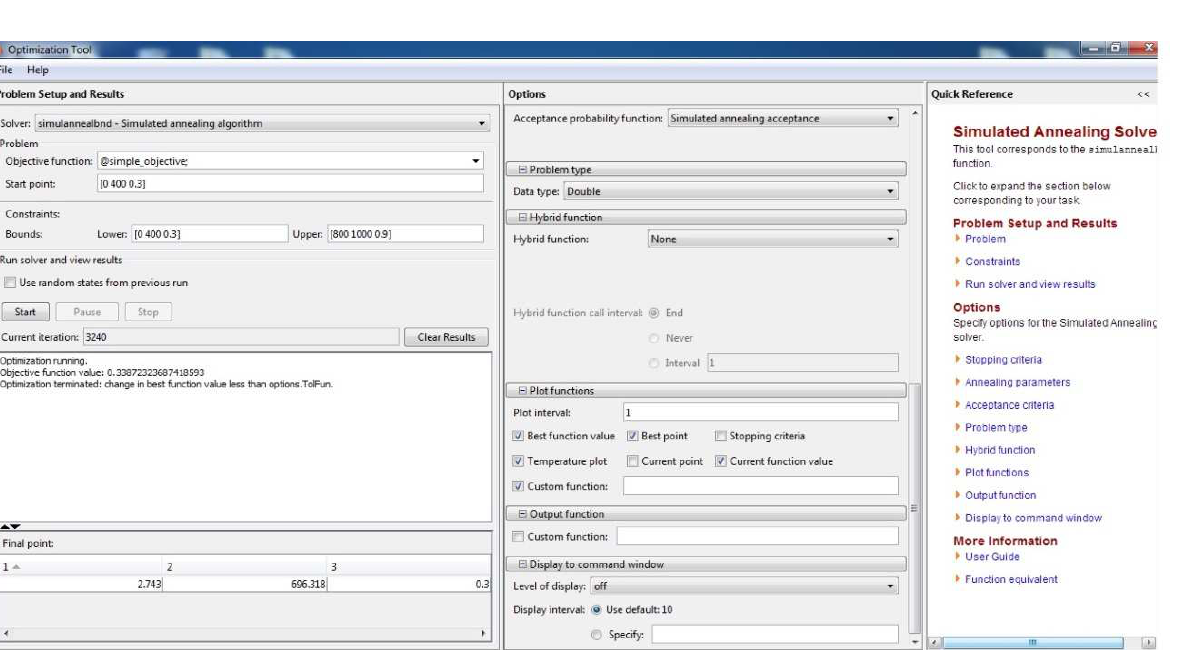
Fig. 9. Applying of Simulated Annealing Algorithm (R